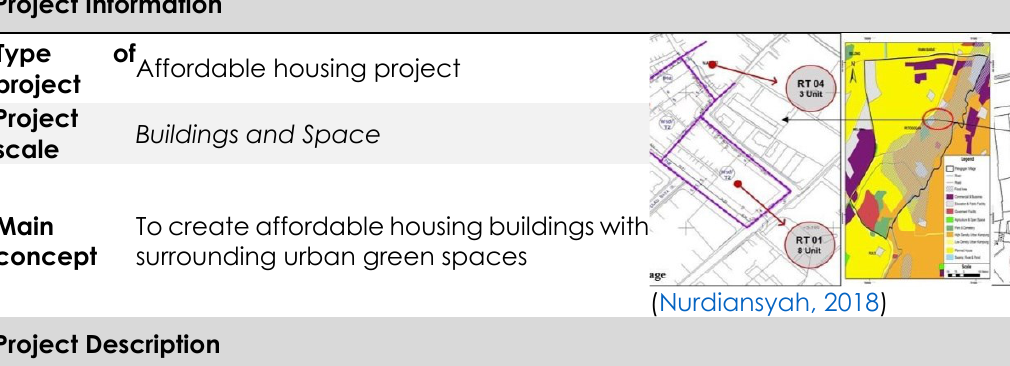
Table 4. Kampung Neighbourhood Upgrading